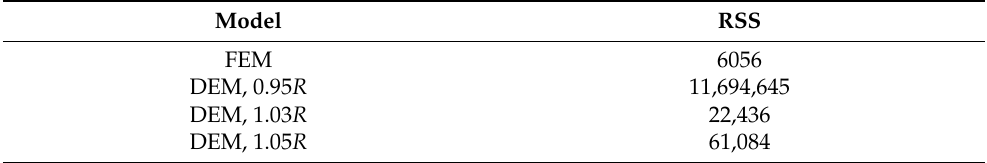
Figure 9. Comparison between dispersion curves for numerical models and Pochhamer-Chree theory. Table 2. Residual sum of squares between numerical models and Pochhammer-Chree theory .